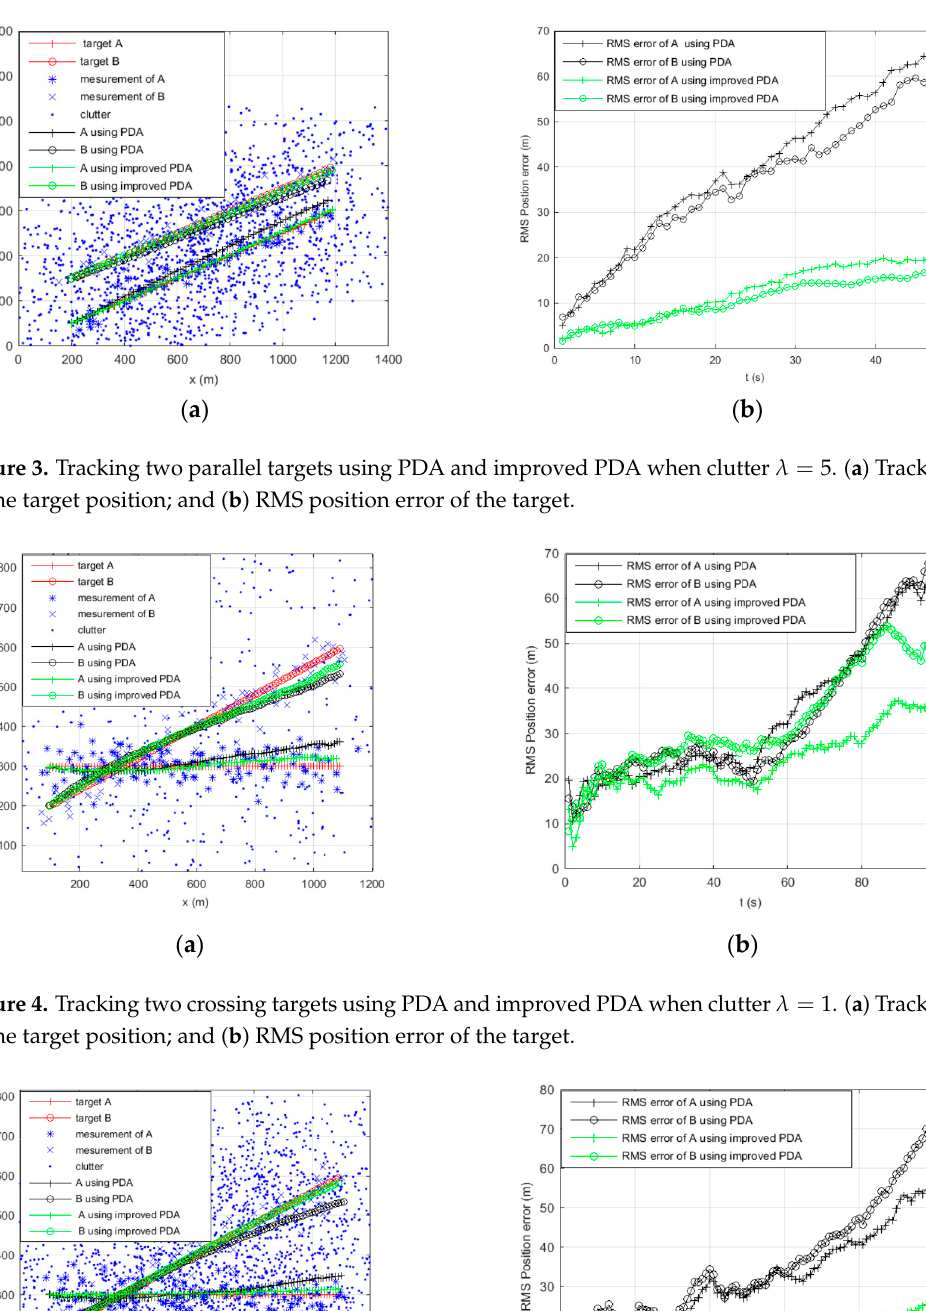
Figure 2. Tracking two parallel targets using PDA and improved PDA when clutter 1 .